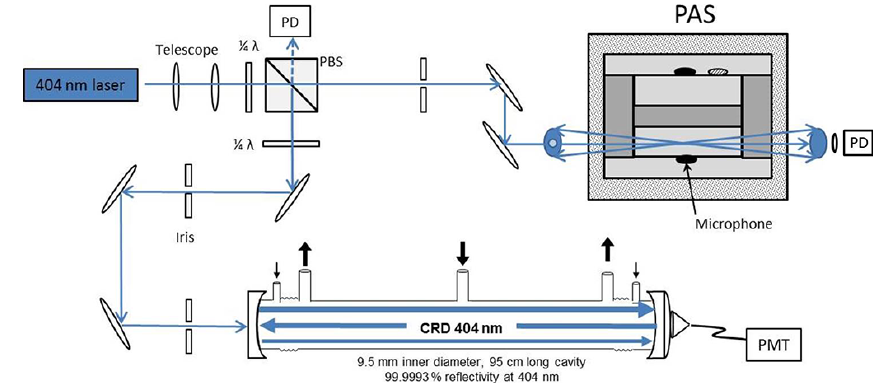
Figure 3. Schematic of the photo-acoustic spectrometer (PAS) coupled to a cavity ring down (CRD) spectrometer (PA-CRD-S). Abbrevia- tions: PBS is polarizing beam splitter; PD is photodiode; PMT is photomultiplier tube. Small black arrows indicate the entrance of the purge flows, and the thicker black arrows the direction of the aerosol flow (Bluvshtein et al., 2016).